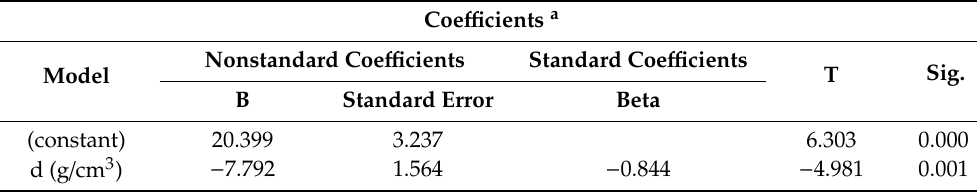
Table 5. Linear regression coe ffi cients: In-situ density and topographic settlement.